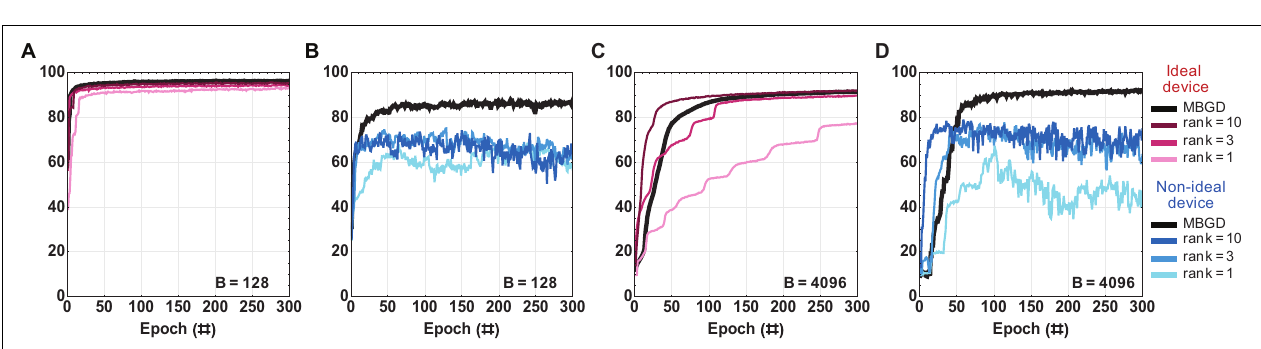
FIGURE 6 | The rank-sum streaming batch PCA results for a multi-layer perceptron with ideal vs. non-ideal memristive weights at different ranks and batch sizes. (A,B) Convergence curves using the rank-sum weight transfer method at batch size = 128; and similarly (C,D) at batch size = 4096. The results show that a low-rank gradient decomposition can approximate the MBGD results fairly well, particularly for ranks 3 and 10. For all these experiments, the rounding method is stochastic and block size = 32.